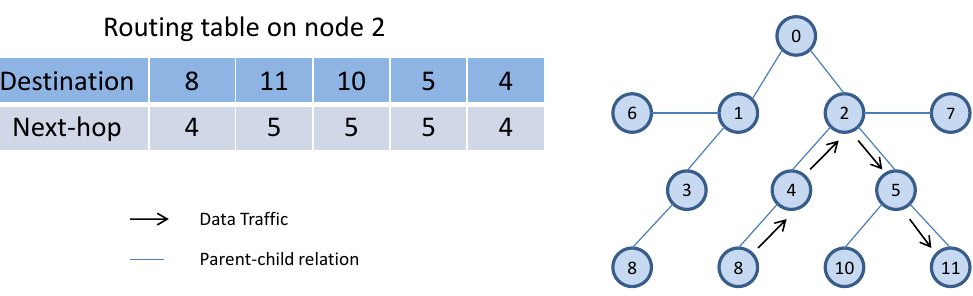
Figure 7. Point-to-point traffic model in